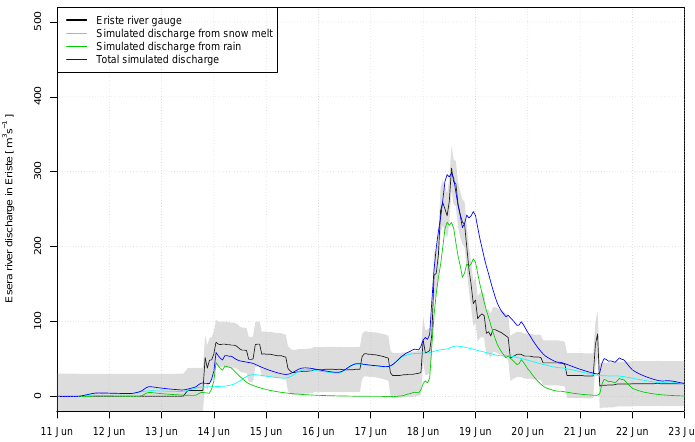
Figure 8. Observed and simulated discharge (total and originated from snowmelt and rain) at Eriste river gauge, error bands in measured discharge are ± 30 m 3 s − 1 which is the pipe discharge of the hydroelectric